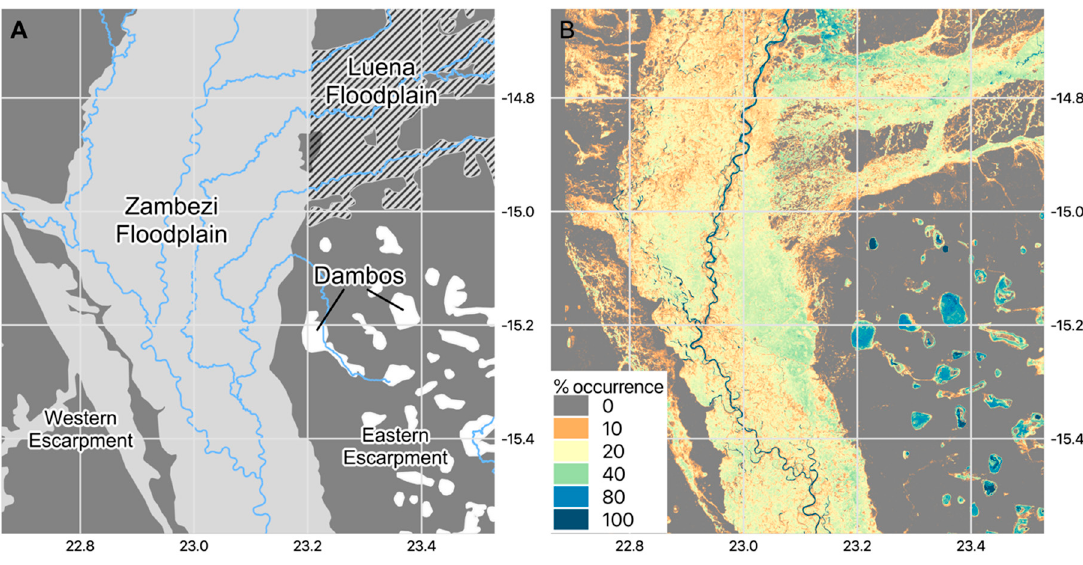
Figure 13. ( A ) Reference maps showing location of key hydrological units. ( B ) Percentage occurrence of mapped water over the studied period,